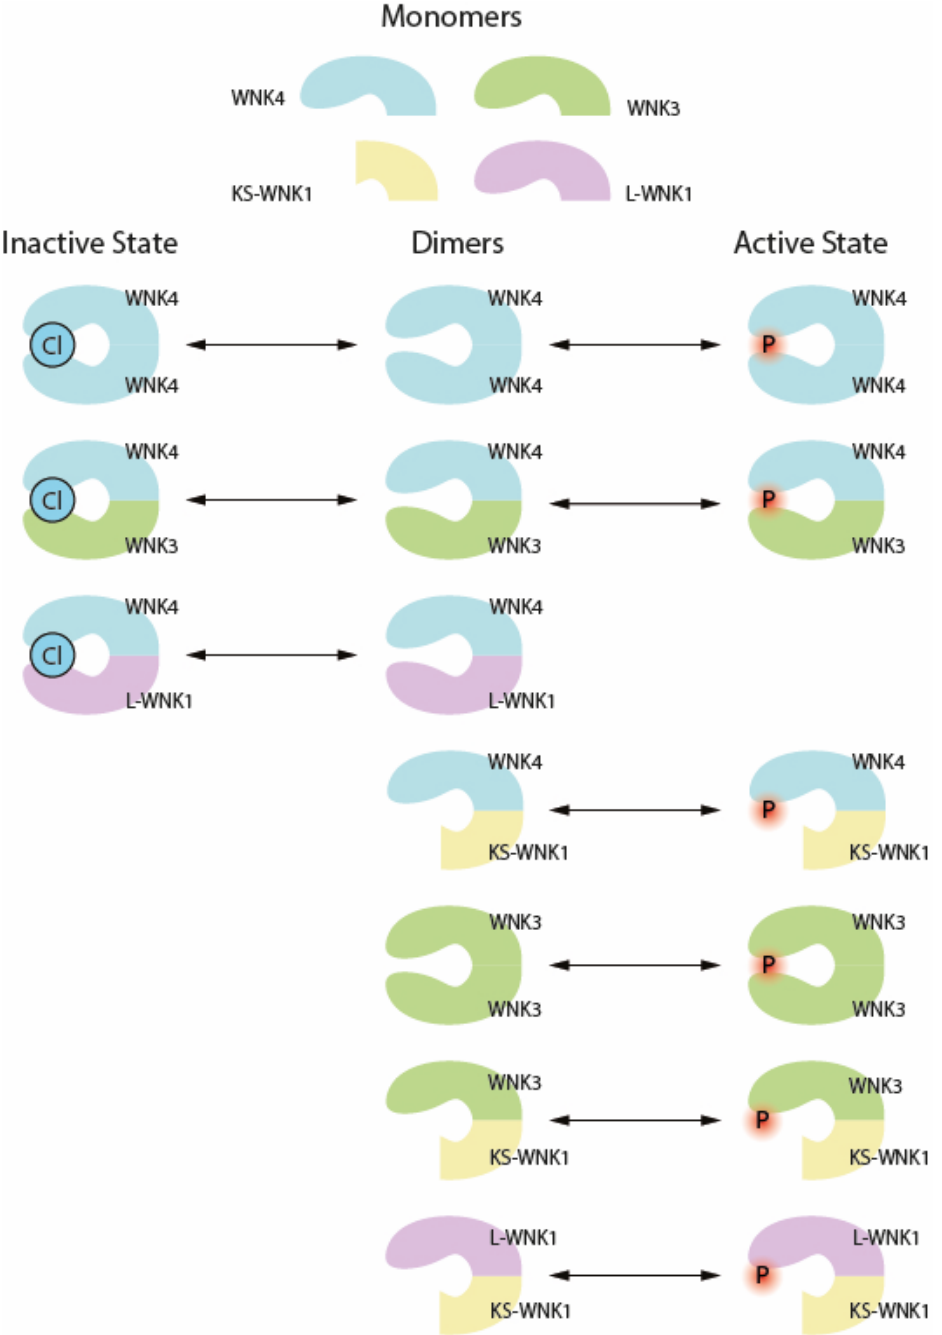
Figure 3. Dynamics of WNK dimer regulation via phosphorylation and chloride binding. Black arrows: state transition catalyzed by the presence of chloride ion.